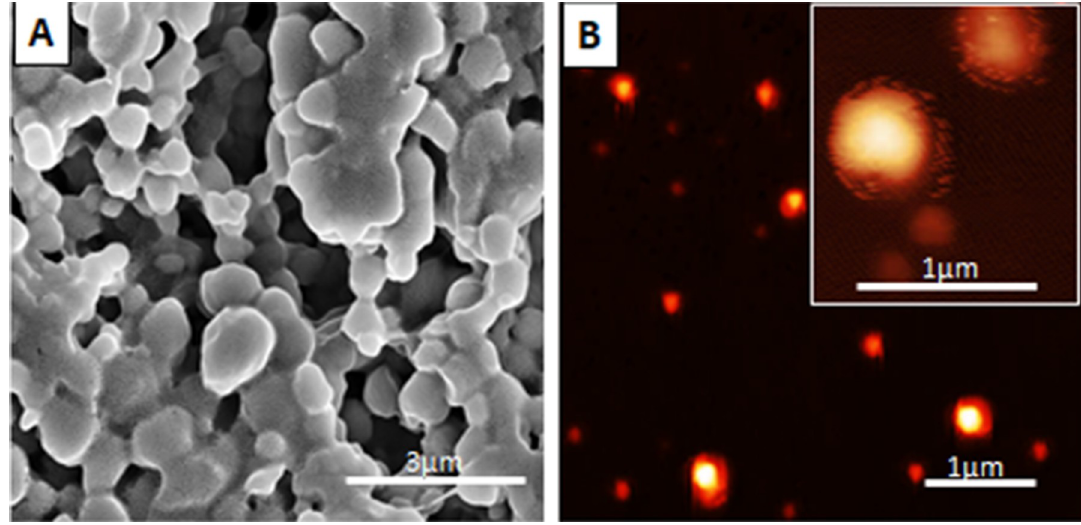
Fig 1. Micrographs of NPMAs. (A) For scanning electron microscopy (SEM), NPMAs were diluted 1:5000 and mounted on plastic coverslips (Thermanox), metalized with gold in an evaporator (Bal-Tec, model MD20) and analyzed by SEM with secondary electrons, backscattered electron imaging and (B) Atomic force microscopy (AFM) image using non-contact mode, sample diluted 1:5000 and deposited in silicon plates.